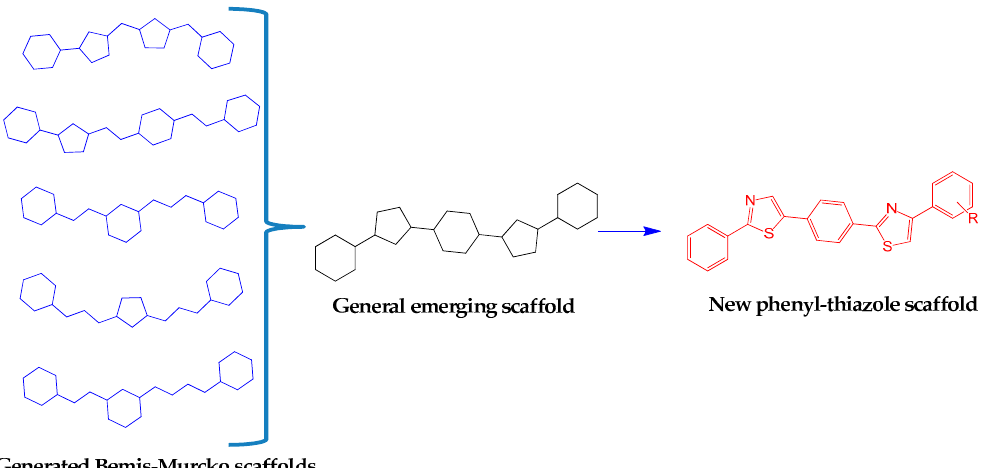
Figure 1. The design strategy for the target compounds.